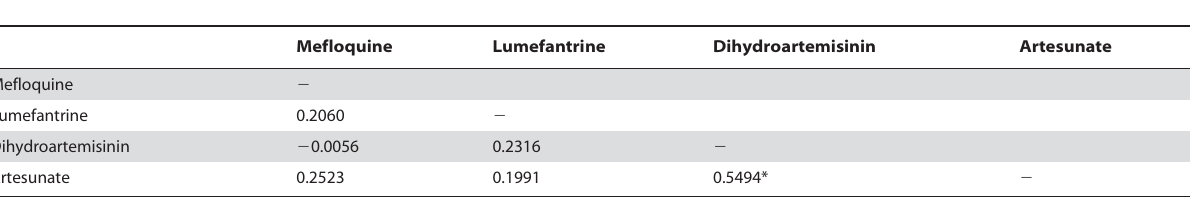
Table 2. Correlation matrix showing Spearman’s correlation coefficients between the four tested drugs.